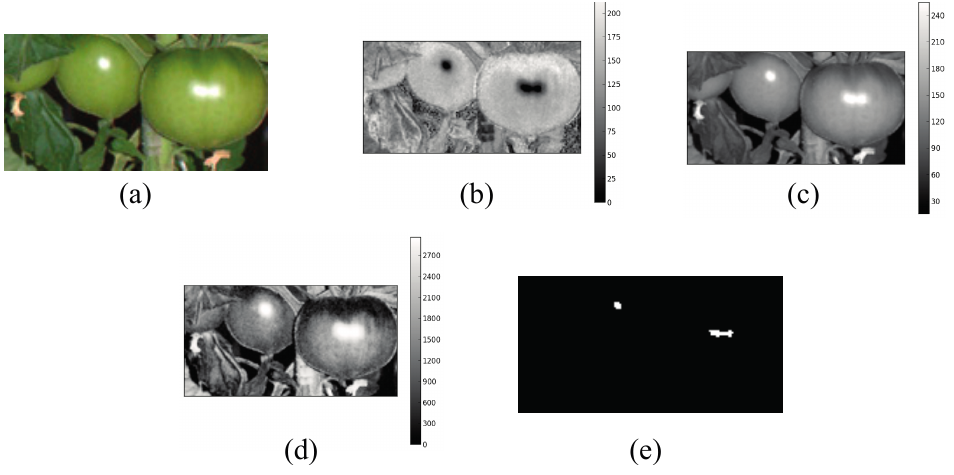
Figure 3. Example of detection of the overexposed regions in a multi-fruit blob. ( a ) Original image; ( b ) Saturation channel in the HSV image; ( c ) Value channel in the HSV image; ( d ) Image generated by multiplication of the value and inverted saturation channels; ( e ) Detected regions by applying X -means